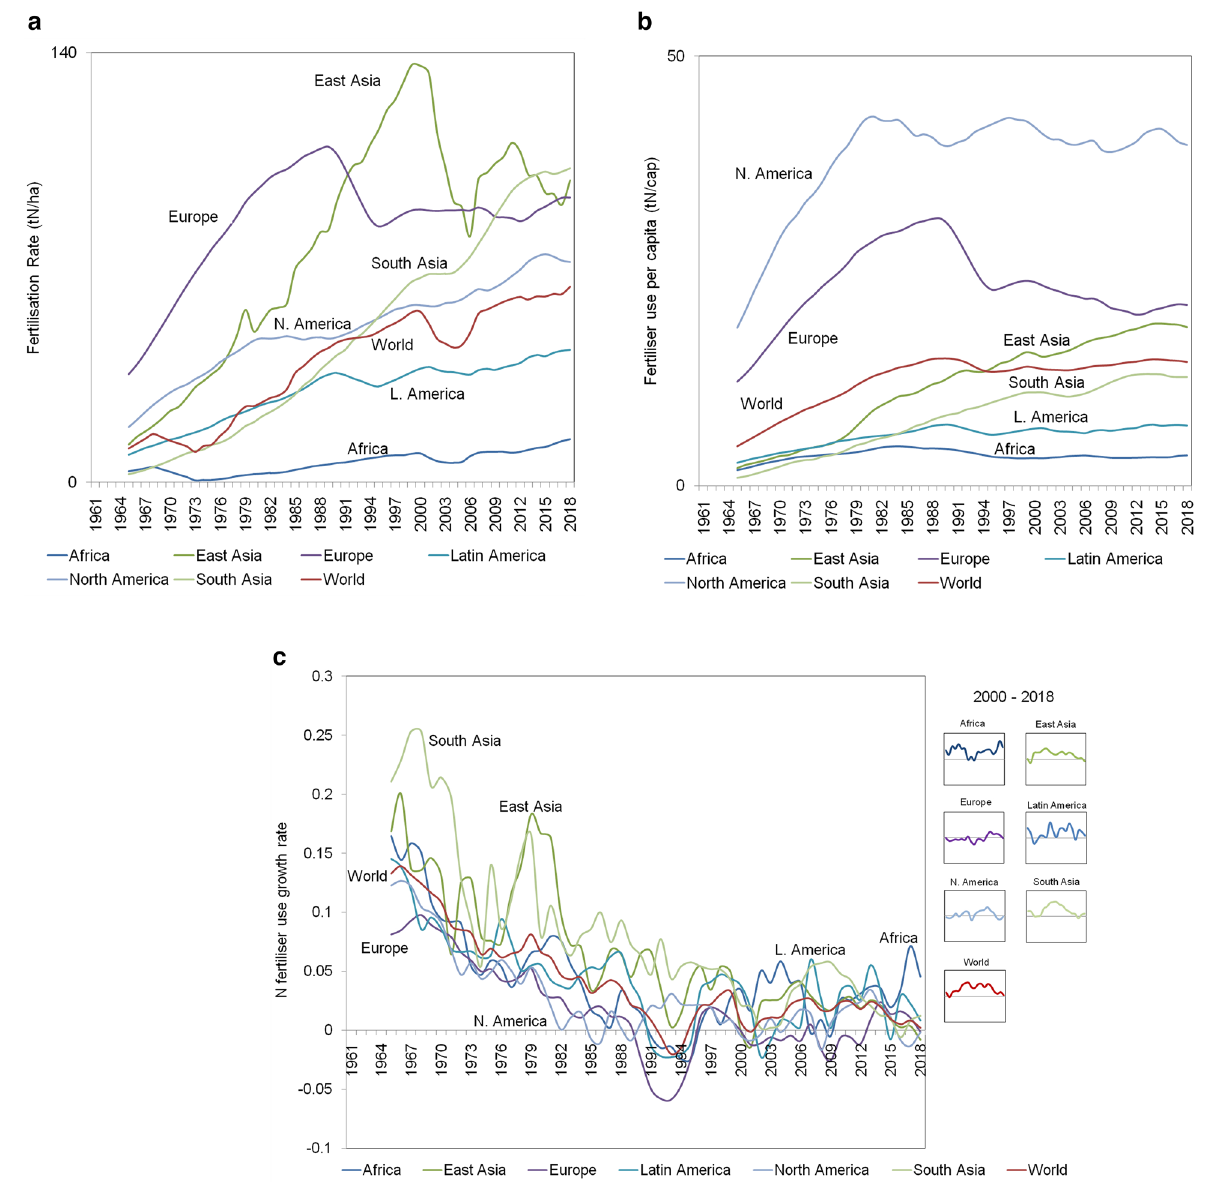
Figure 3. ( a ) Fertilisation rate, N fertiliser applied per unit of cropland (kgN/ha); ( b ) amount of synthetic N fertiliser used (kg) per capita; ( c ) synthetic N fertiliser use: yearly growth rate for different world regions.